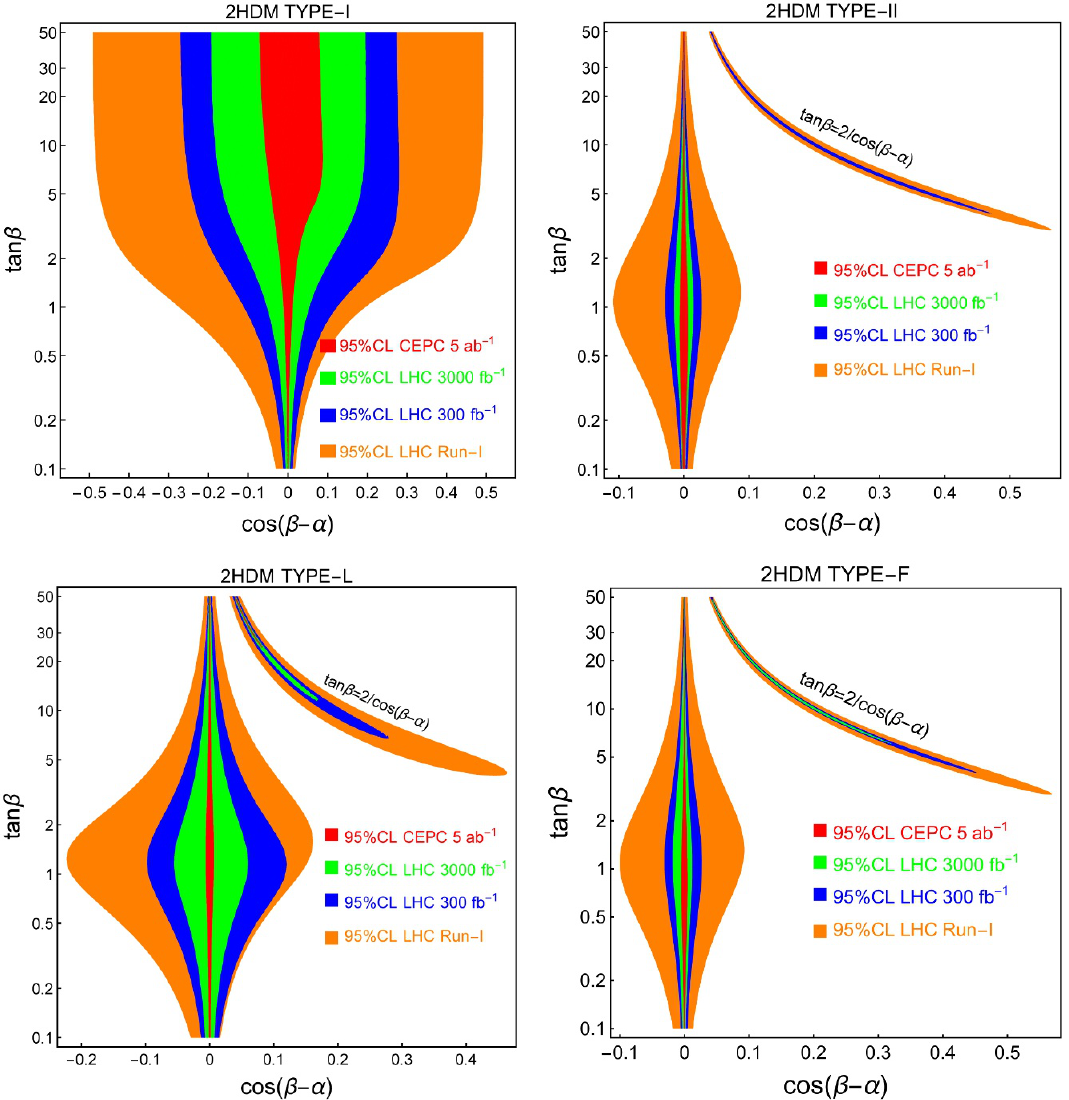
Figure 2 . The allowed region in the plane of tan (cid:12) vs. cos( (cid:12) (cid:0) (cid:11) ) at 95% C.L. for the four types of 2HDM, given LHC and CEPC Higgs precision measurements. For future measurements, we assume that the measurements agree with SM predictions. The special \arm" regions for the Type-II, L and F are the wrong-sign Yukawa regions. See text for more